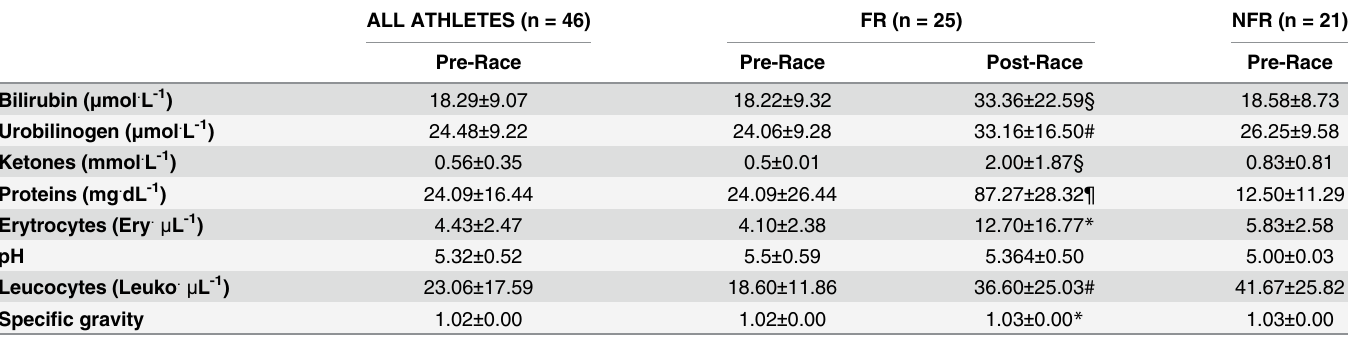
Table 3. Urine standard analysis.